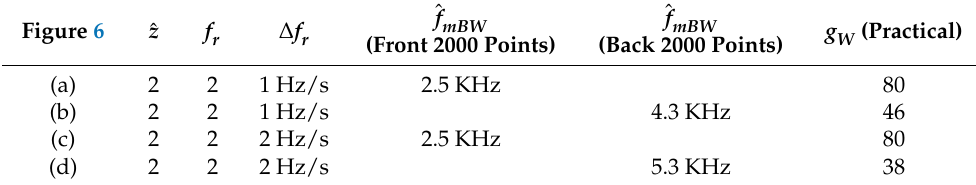
Table 3. Calculation of each parameter in Figure